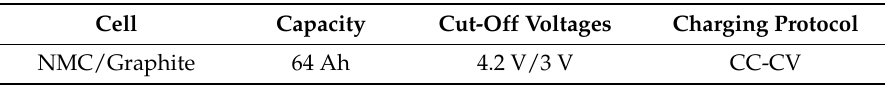
Table 1. NMC cell technical